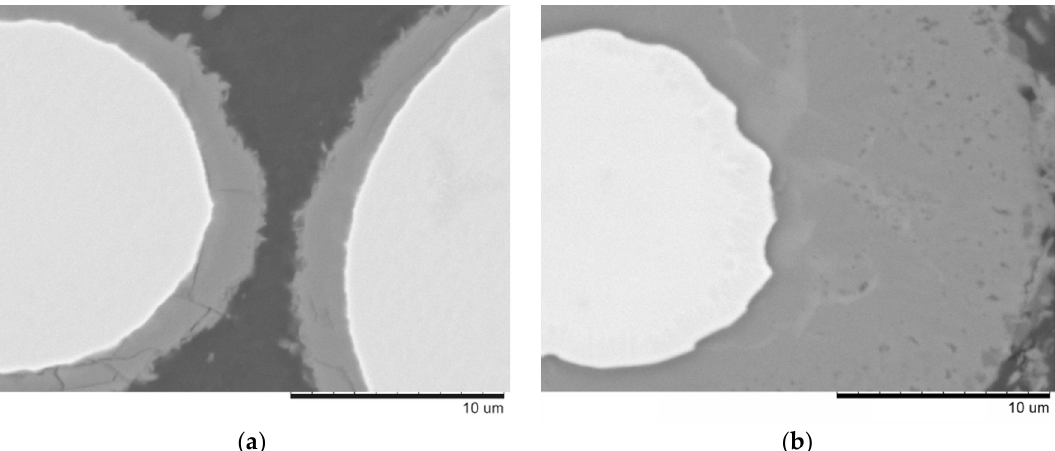
Figure 4. Reaction layer formed at the interface: ( a ) composite sintered at 540 °C, 3 min, ( b ) composite sintered at 570 °C, 3 min. BSE images.